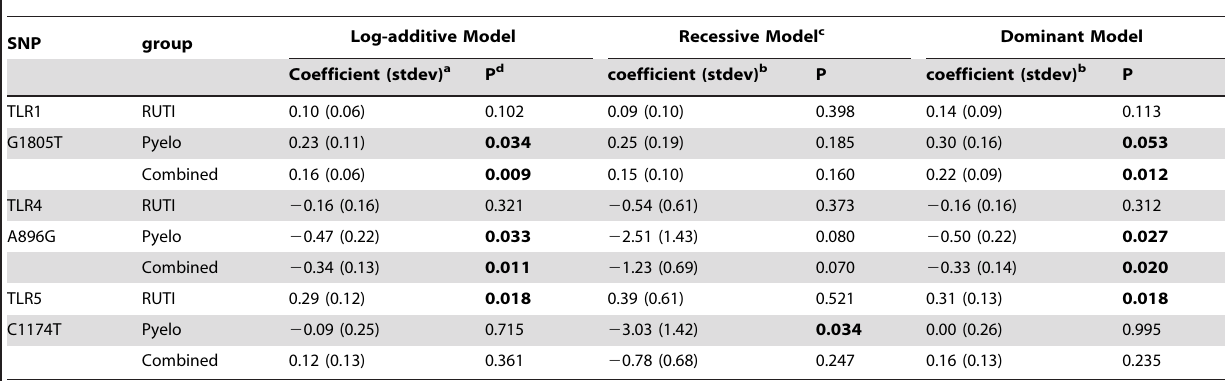
Table 4. Analysis of 3 Functional TLR SNPs with UTI Disease